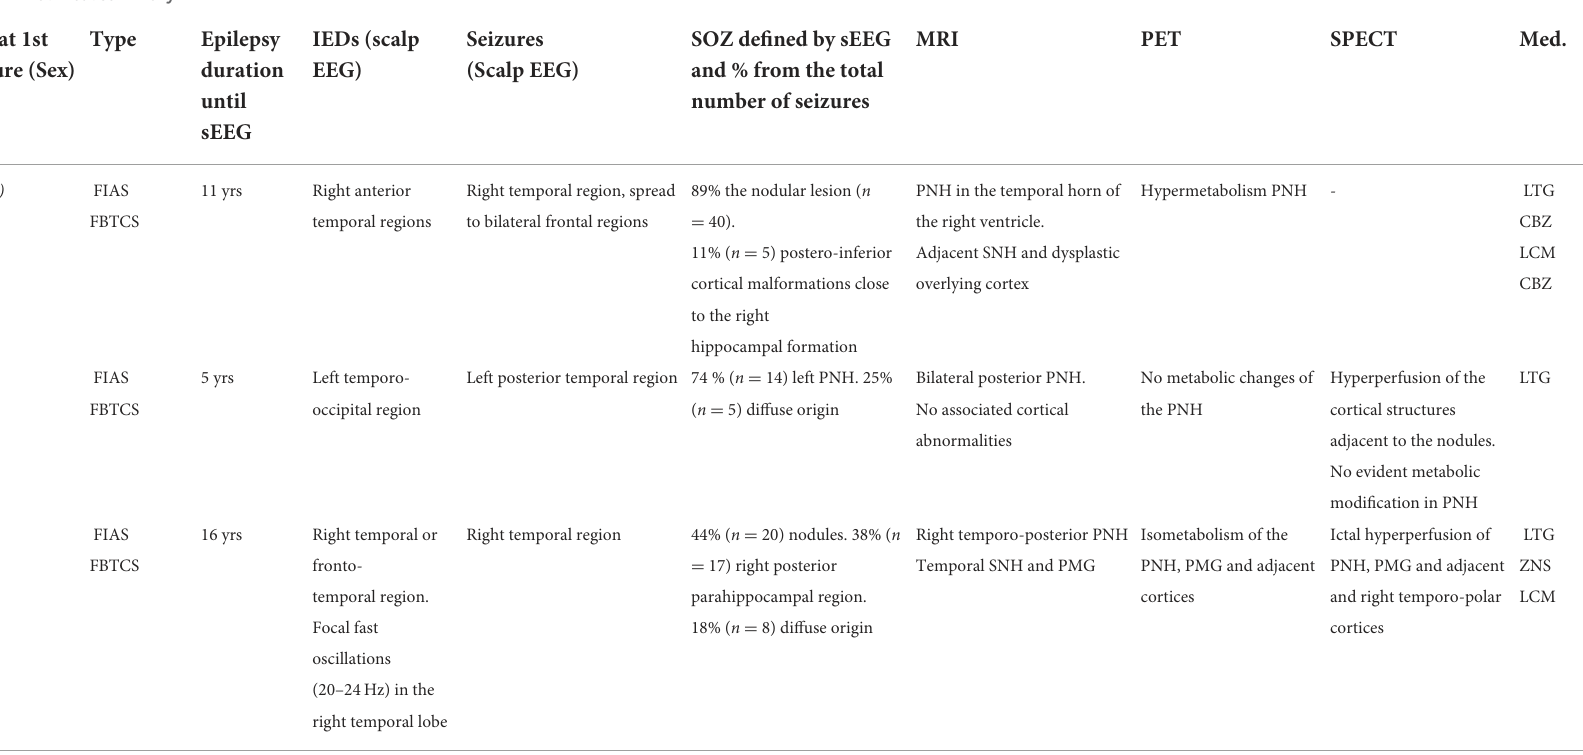
TABLE 1 Clinical